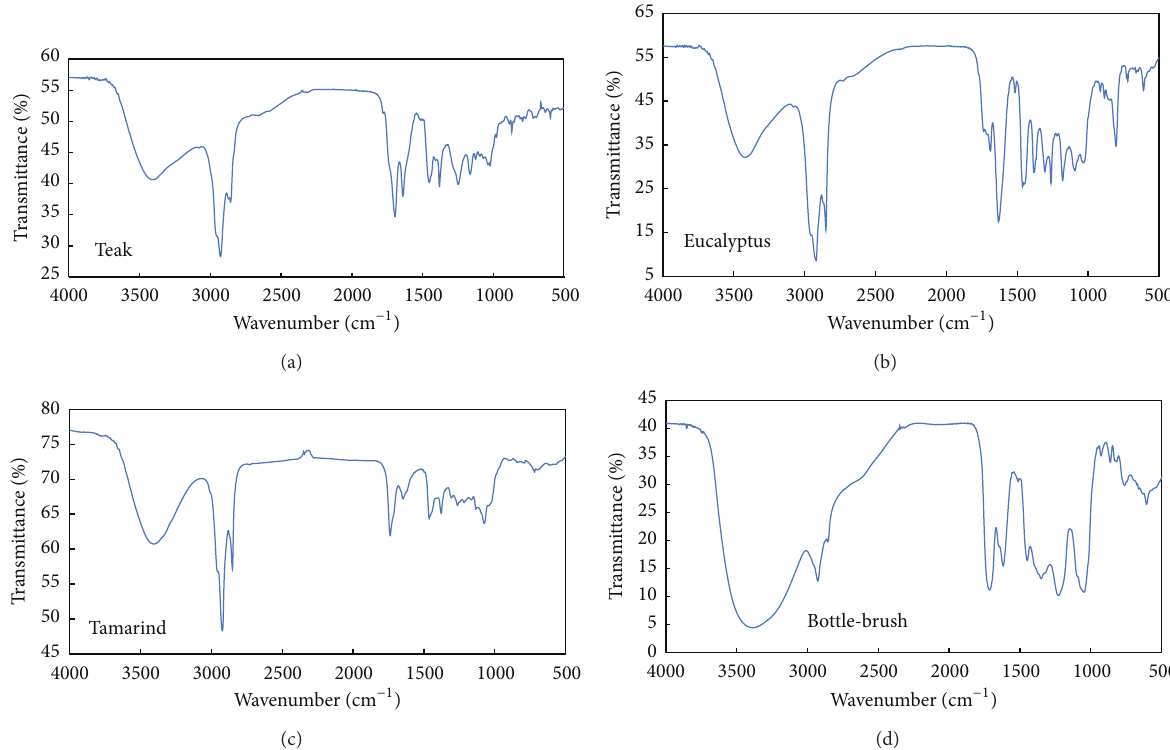
Figure 5: Infra-red spectra of extracts obtained from (a) teaks (b) tamarinds (c) eucalyptuss and (d) bottle brush.